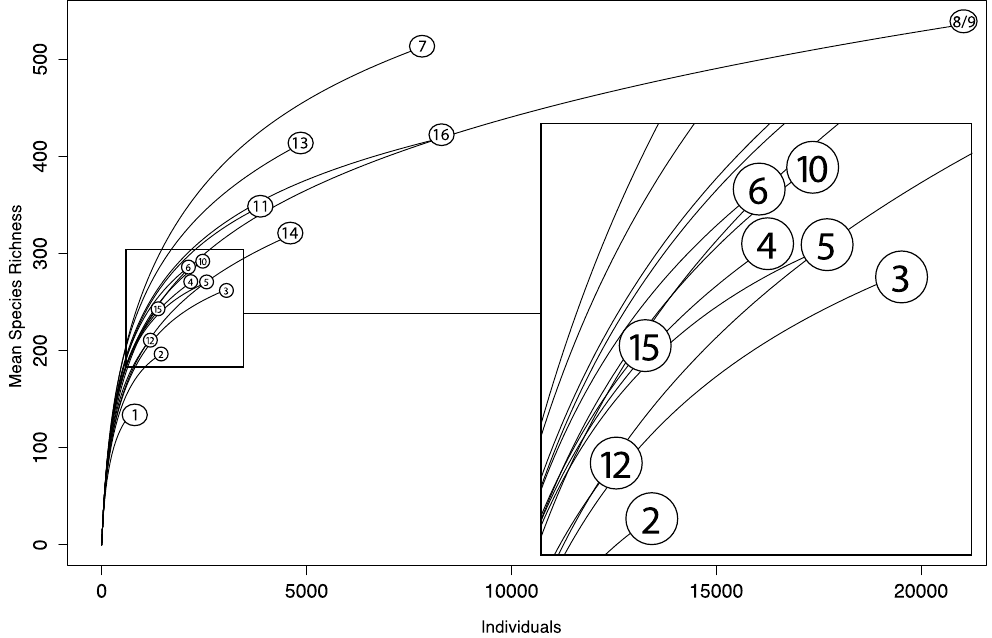
Figure 7. Rarefaction analysis conducted on the 16 zones. The zone numbers are referenced at the end of each line.